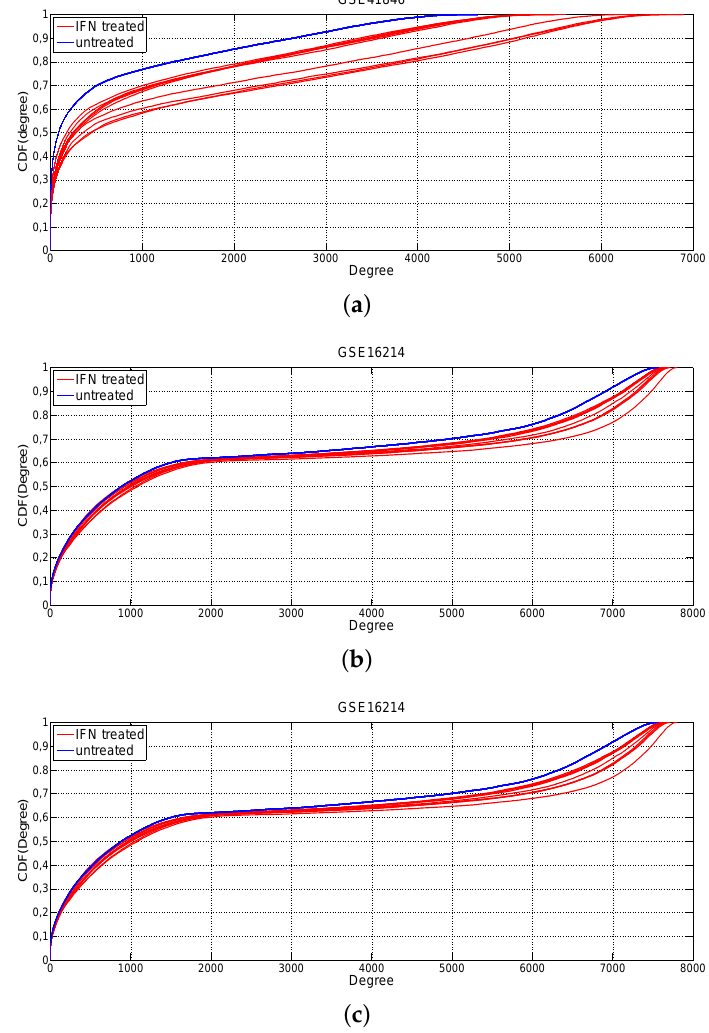
Figure 3. Cumulative distribution functions of the gene degree. Comparison between IFN-treated (blue color) and untreated (red color) MS patients by using the GSE41846, GSE41847 and GSE16214 GEO datasets. ( a ) GSE41848; ( b ) GSE41847; ( c )